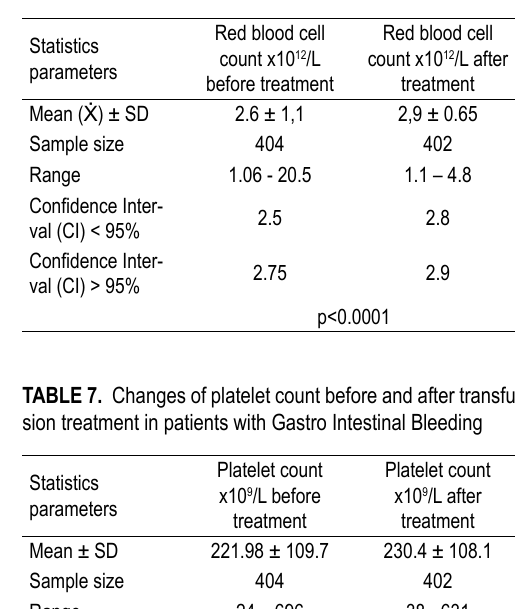
Table 5. changes of erythrocytes count before and